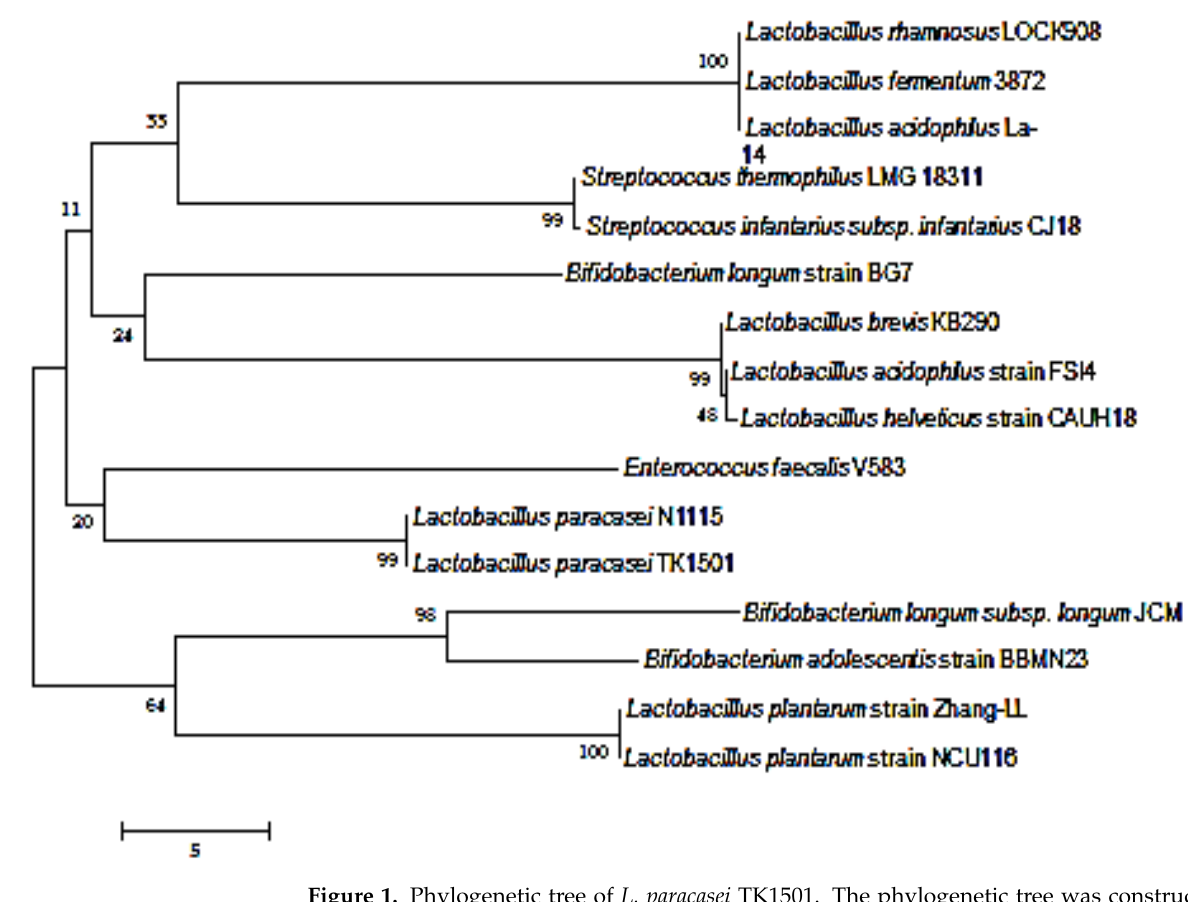
Figure 1. Phylogenetic tree of L. paracasei TK1501. The phylogenetic tree was constructed using MEGA 6.0. Table 1. Comparison of genistein production in the soymilk after fermentation using the different lactobacillus